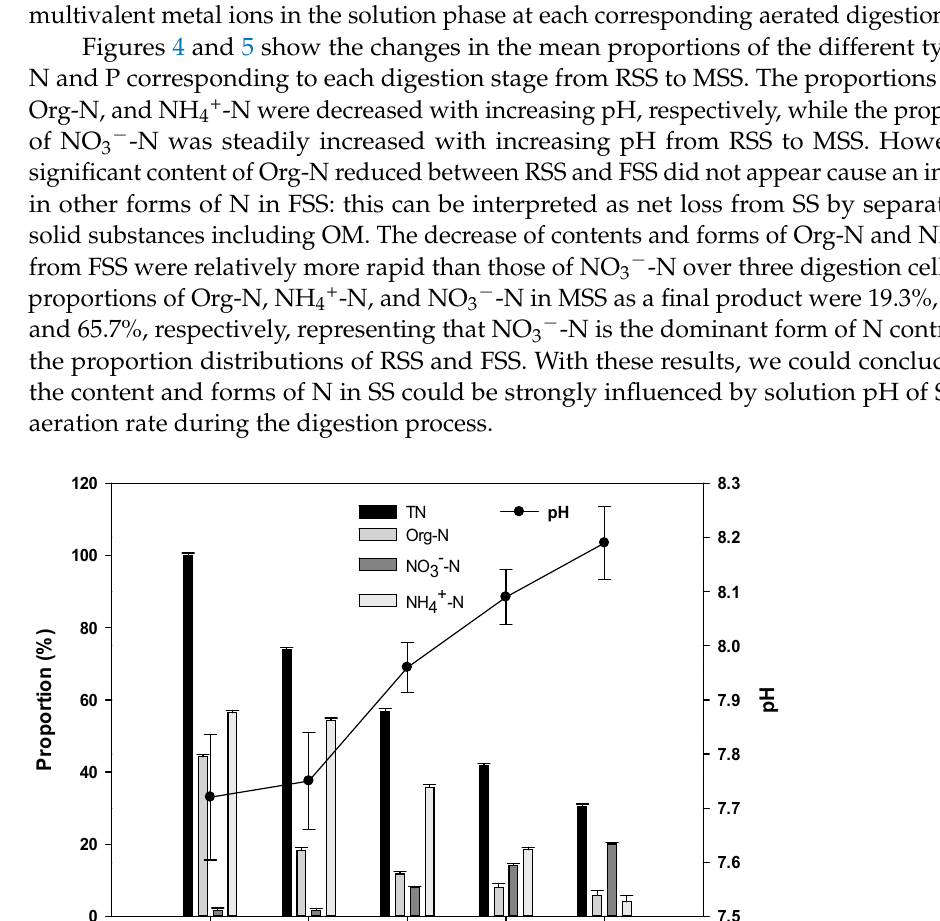
Figure 5. Changes in proportion of P content and pH corresponding to each digestion stage. TP, total phosphorus; Org-P, organic phosphorus; PO 43 − -P, phosphate. Error bars indicate standard er- ror.